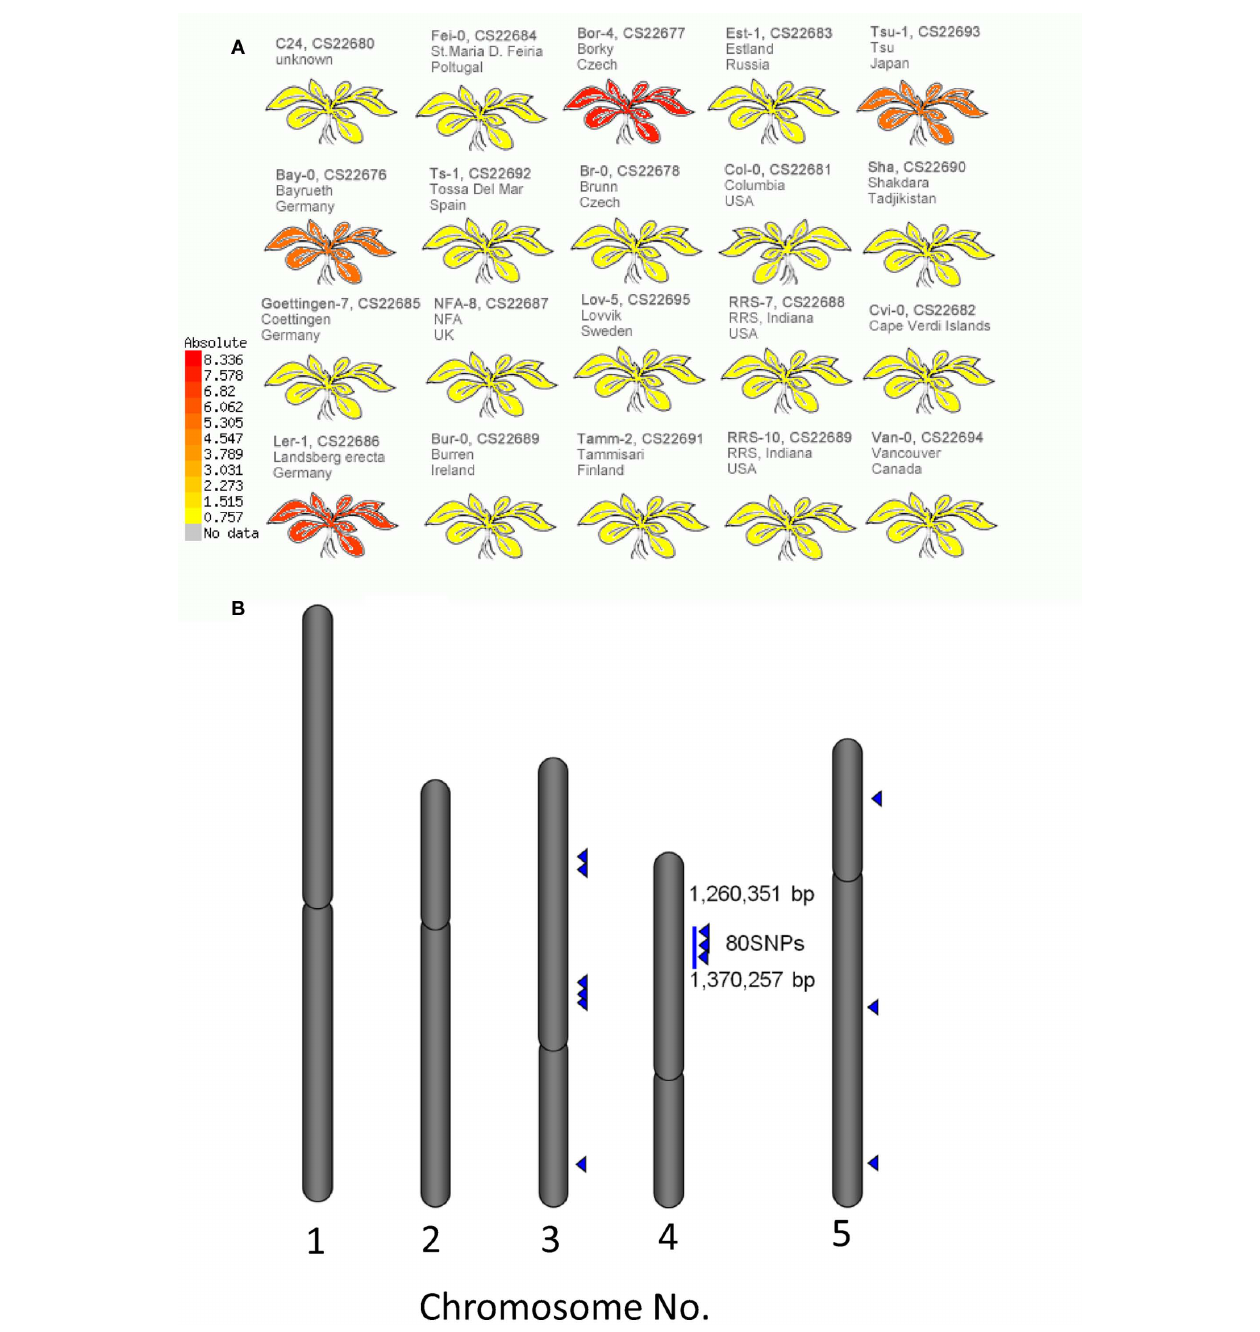
Figure 6 | Association between levels of 3-hydroxy-n-propylglucosinolate and single nucleotide polymorphisms (SNPs) across 20 accessions of Arabidopsis . (A) Heat-map representation of 3-hydroxy-n-propylglucosinolate